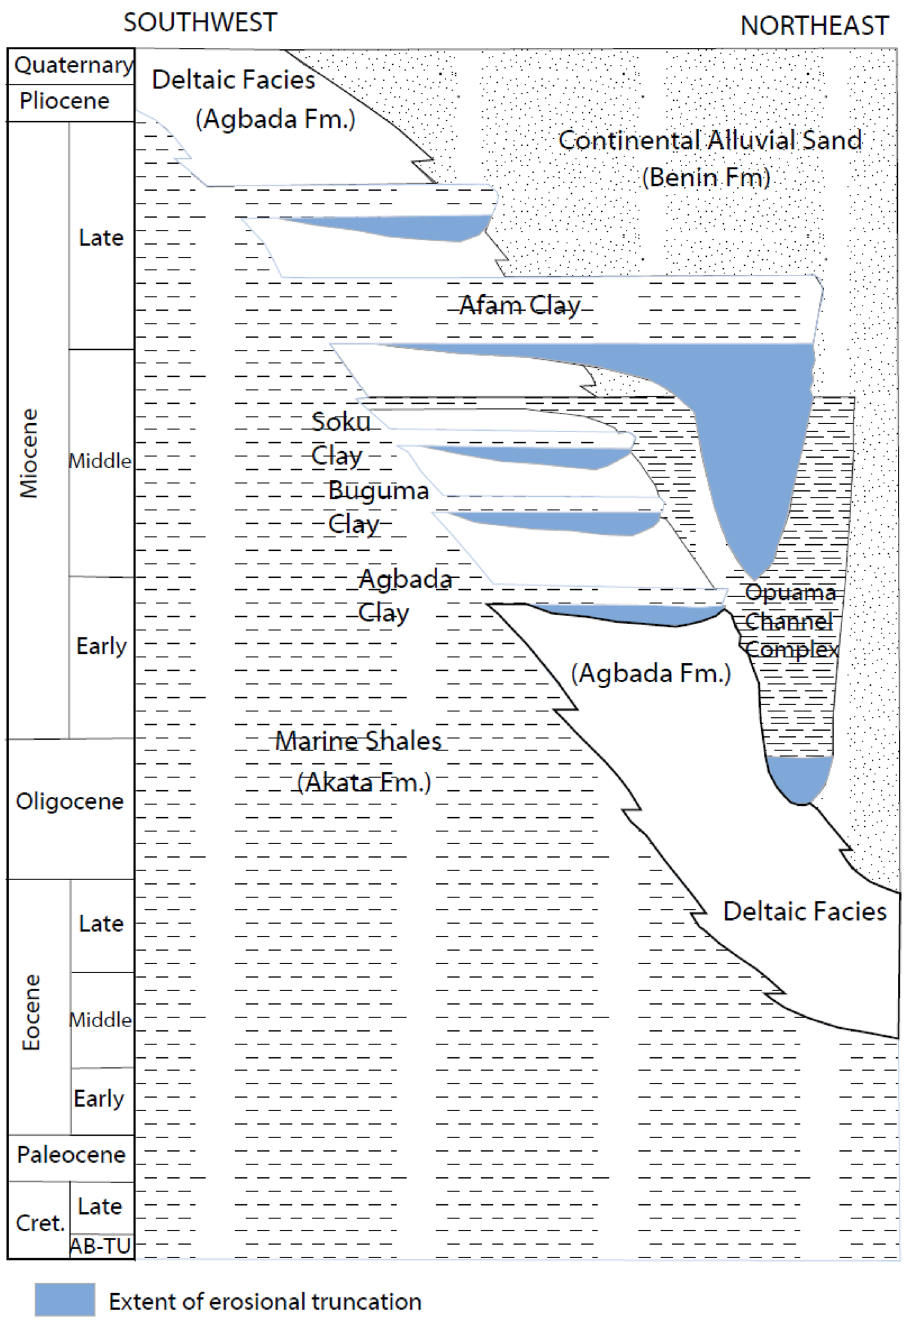
Fig. 2 Stratigraphic column